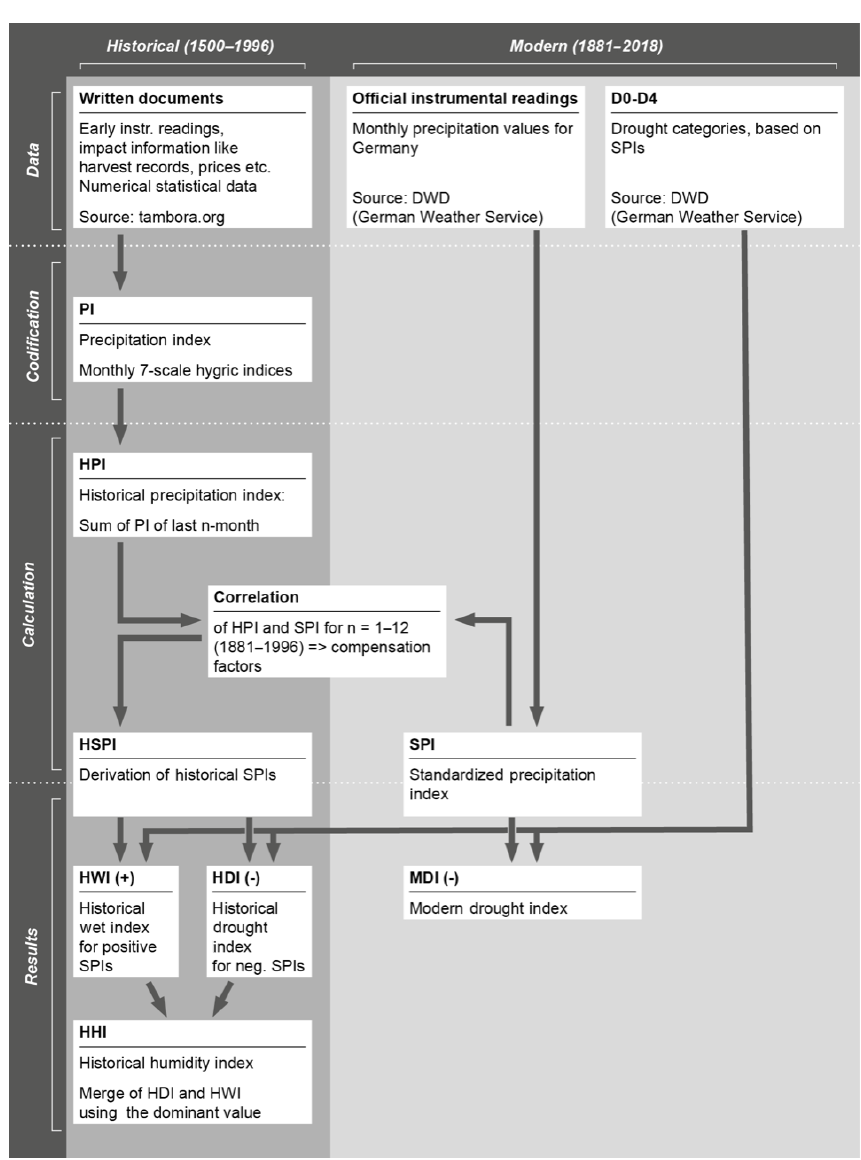
Figure 2. Conceptual design of the analysis, illustrating the workflow and the single steps from which the specific indices and their relations are derived. Table 1. Abbreviations of the developed